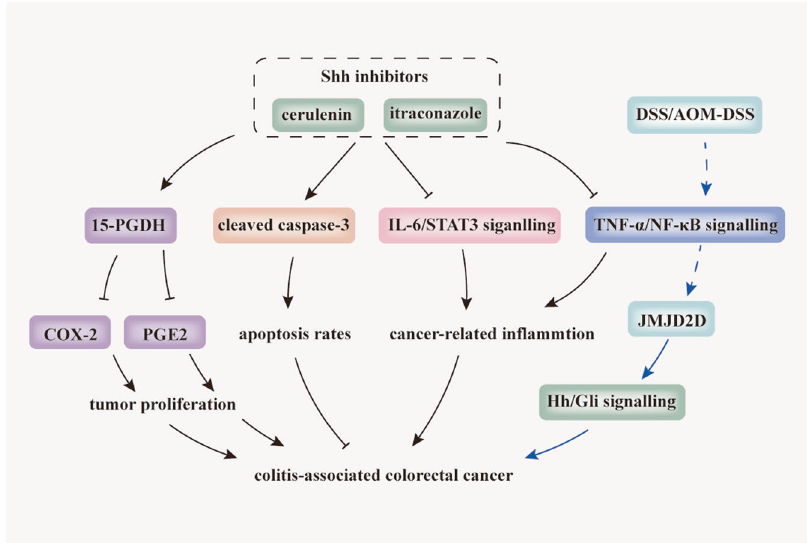
Fig. 3 Inhibition of Hh signalling prevents tumourigenesis and CAC progression. Shh inhibitors, including cerulenin and itraconazole, play a potent suppressing role on carcinogenesis-associated in fl ammation by downregulating IL-6, IL-6-associated signal transducer and activator of transcription 3 (STAT3) signalling, and NF- κ B-related TNF- α . Moreover, Shh inhibitors induce apoptosis by elevating cleaved caspase-3 and exert an anti-proliferating effect by elevating 15-hydroxyprostaglandin dehydrogenase (15-PGDH), a prostaglandin E2 (PGE2)-degrading and tumour-suppressive enzyme. This subsequently inhibits cyclooxygenase-2 (COX-2). In addition, activation of Hh signalling by TNF- α /NF- κ B- generated overexpression of the histone demethylase, JMJD2D, can be impaired by DSS or AOM/DSS and promotes tumourigenesis and CAC metastasis. Blue lines indicate evidence from two separate studies. Arrows, blunt ends, and dotted lines indicate activation, inhibition, and indirect regulatory effects, respectively. 15-PGDH 15-hydroxyprostaglandin dehydrogenase, PGE2 prostaglandin E2, COX-2 cyclooxygenase-2; IL-6 interleukin-6, STAT3 signal transducer and activator of transcription 3, JMJD2D jumonji domain-containing protein 2D, TNF- α /NF- κ B Tumour necrosis factor- α /nuclear